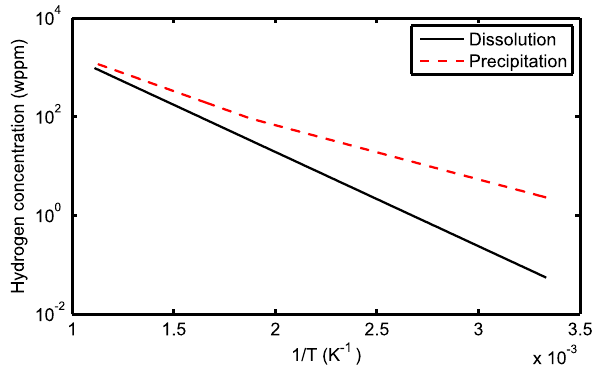
Figure 14. Solid solubility limits for hydrogen in Zircaloy versus inverse temperature, i.e. hydride dissolution and precipitation. The Arrhenius plots are based on measurements of Une and Ishimoto 40 in the temperature range of about 320 to 900